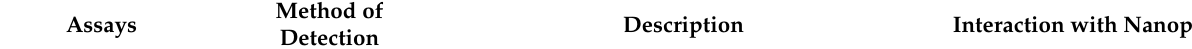
Table 2. Different cytotoxicity assays for the evaluation of